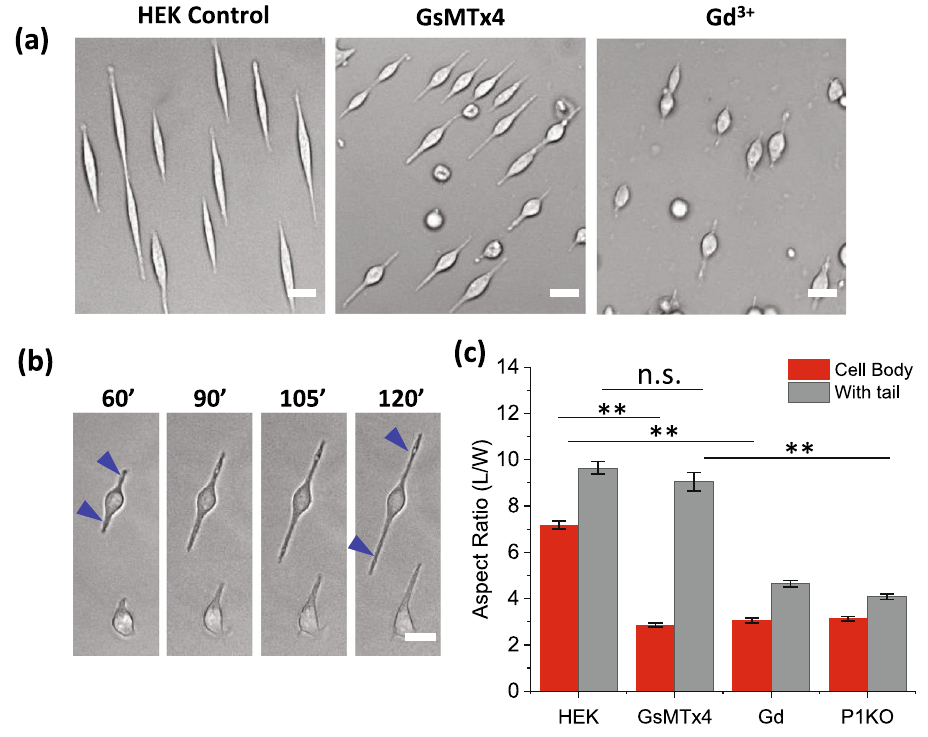
Figure 2. Effect of Piezo1 inhibitors on cell spreading on patterns. (a) HEK cells grown on fibronectin stripes in control solution, GsMTx4 (20 µM), and Gd 3+ (60 µM) for 2.5 h, showing inhibiting Piezo1 channels eliminated cell expansion. Drugs were added 15 min after seeding. ( b) Cell reshaping on stripes in the presence of GsMTx4, showing thin tail-like spikes (indicated by blue arrows) while the cell body remained unchanged. (c) Mean aspect ratios (with and without counting the tail length) of cells in media and in the presence of inhibitors (n = 120 for each condition and from multiple experiments, **p < 0.001). Scale bars represent 20